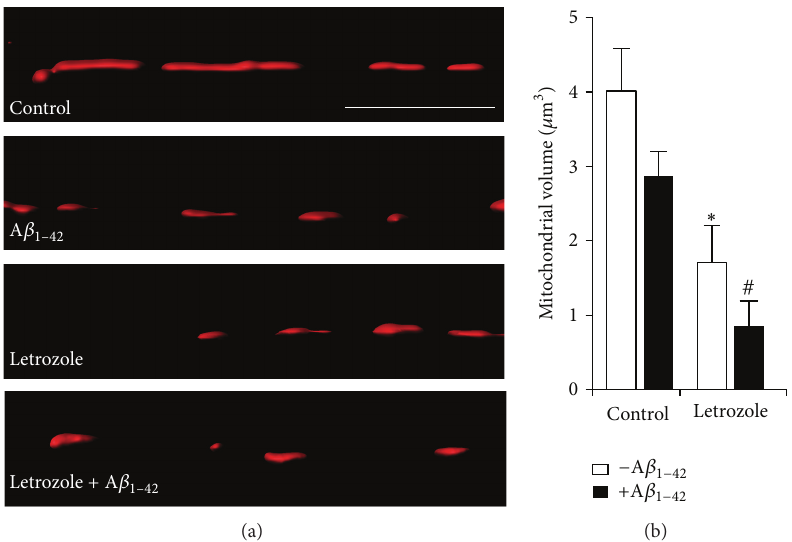
Figure3: Letrozoleand 𝐴𝛽 1 causesignificantchangesinmitochondrialmorphology. (a)Representative3DreconstructionsofMitoTracker – 42 (1 𝜇 M) for 24 hours in the presence and Deep Red FM-positive mitochondria from hippocampal dendritic segments treated with 𝐴𝛽 1 – 42 absence of 3-day letrozole (1 𝜇 M) treatment. Scale bar, 5 𝜇 m. (b) Quantifications of mitochondrial volumes. Significant differences in mitochondrial volume, compared to control cultures ( 4.03 ± 0.56 𝜇 m 3 ), were observed for letrozole- ( 1.72 ± 0.49 𝜇 m 3 , 𝑃 = 0.015 ) treated ( 𝑃 = 0.25 ), it cultures, as indicated by ( ∗ ). Although there is no significant difference in mitochondrial volume between control and 𝐴𝛽 1 – 42 ( 2.88 ± 0.32 𝜇 m 3 ) was observed in letrozole + 𝐴𝛽 1 treated is noteworthy that further reduction in mitochondrial volume relative to 𝐴𝛽 1 – 42 – 42 cultures ( 0.86 ± 0.33 𝜇 m 3 , 𝑃 = 3.37 × 10 −4 ) and is signified by